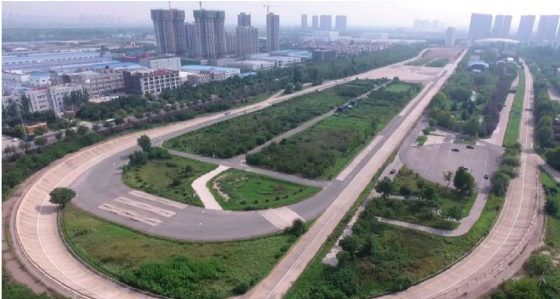
Figure 1: CAVTest field of Chang’an